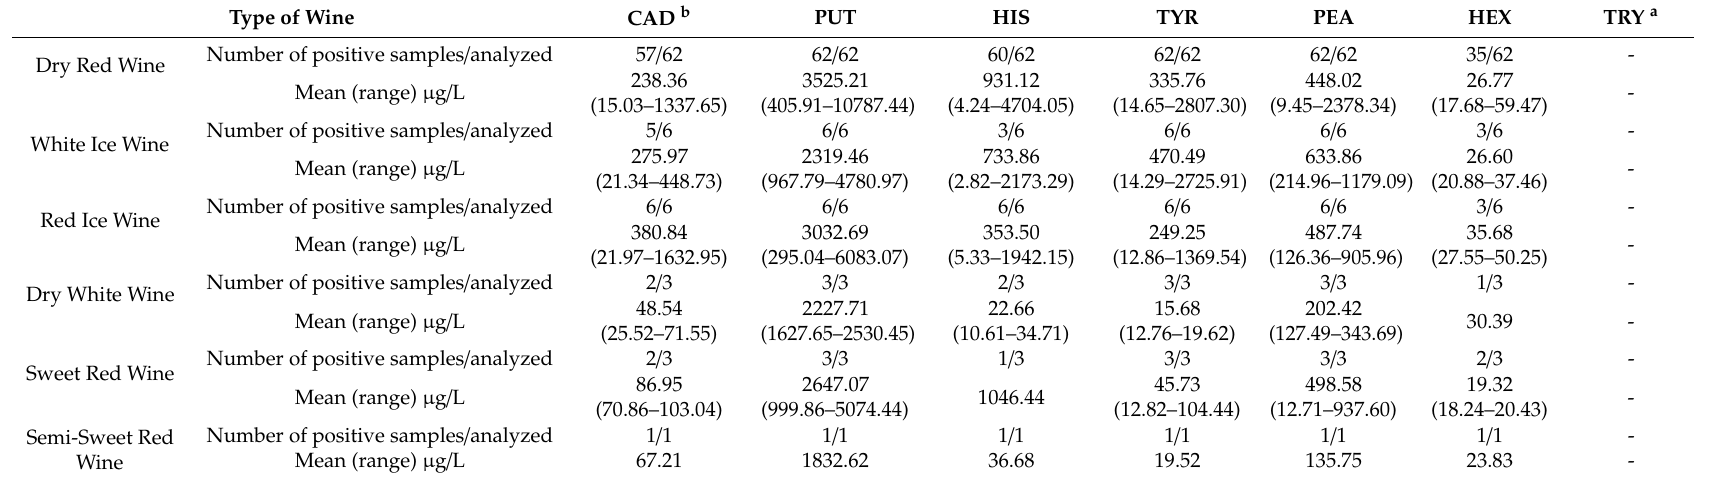
Table 3. BA occurrence in di ff erent types of wine